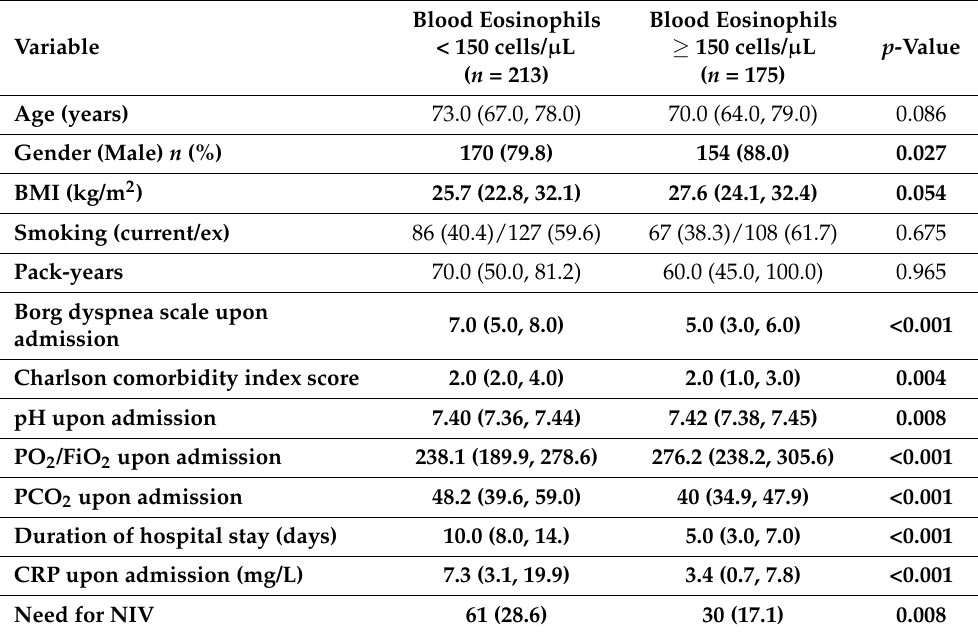
Table 1. Demographic and functional characteristics of the study participants.